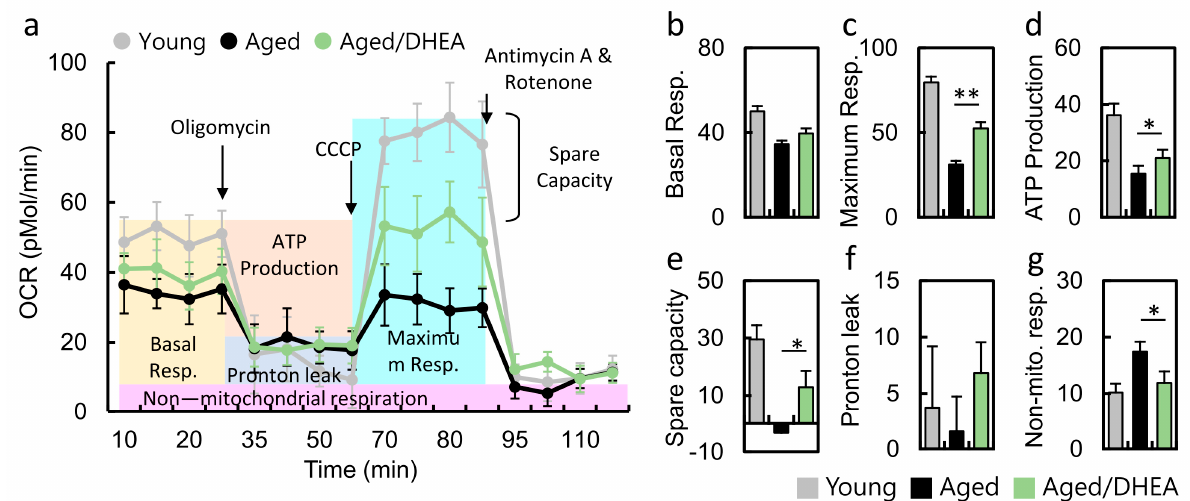
Figure 4. Metabolic reprogramming in the cumulus cells of aged infertile patients after DHEA treatment. (a) Mitochondrial function was determined by oxygen consumption rate (OCR), through utilizing the Seahorse Bioscience Analyzer. (b-g) All of the OCR values at different phases of basal respiration, maximal respiration, ATP-coupled respiration, and spare capacity, proton leak and noon-mitochondrial respiration were recorded, and the values were calculated among the young, aged and aged/DHEA groups. Oligomycin (1 uM), FCCP (1 uM), antimycin (0.5 uM), rotenone (0.5 uM). * p < 0.05 and ** p <